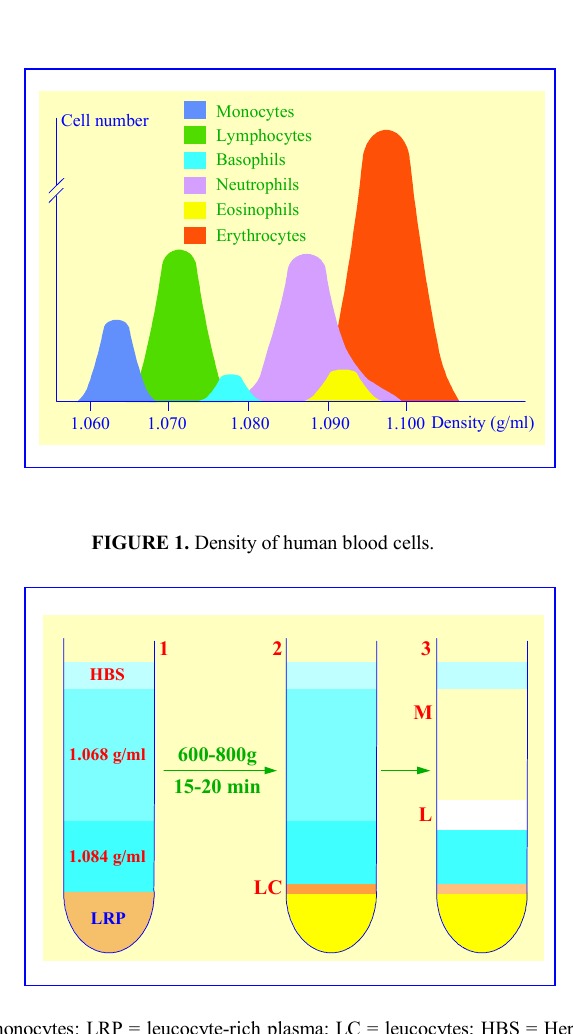
FIGURE 2. Isolation of human monocytes: LRP = leucocyte-rich plasma; LC = leucocytes; HBS = Hepes-buffered saline-BSA. LC form a sharp band during centrifugation (1-2) from which monocytes (M) and lymphocytes (L) separate by